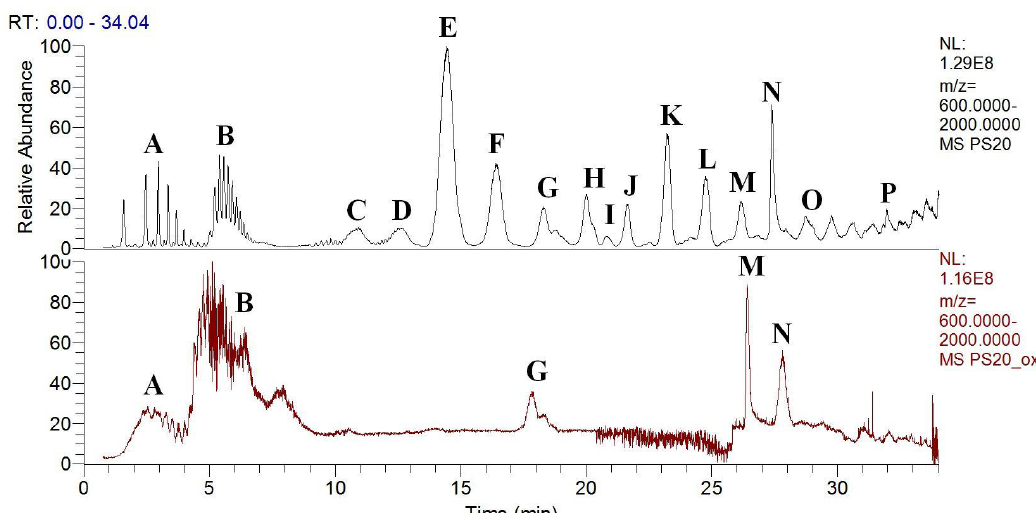
Figure 9. Total ion current (Mr ≥ 600 Da) chromatograms of non-degraded (top) and degraded (bottom) PS20 after oxidation with Cu(II) and ascorbate, and following UHPLC-HRMS. The subspecies in the non-degraded PS20 were identified as: A , unesterified polyoxyethylene isosorbides; B , unesterified polyoxyethylene sorbitans; C , monoesters with caprylic acid; D , monoesters with capric acid;